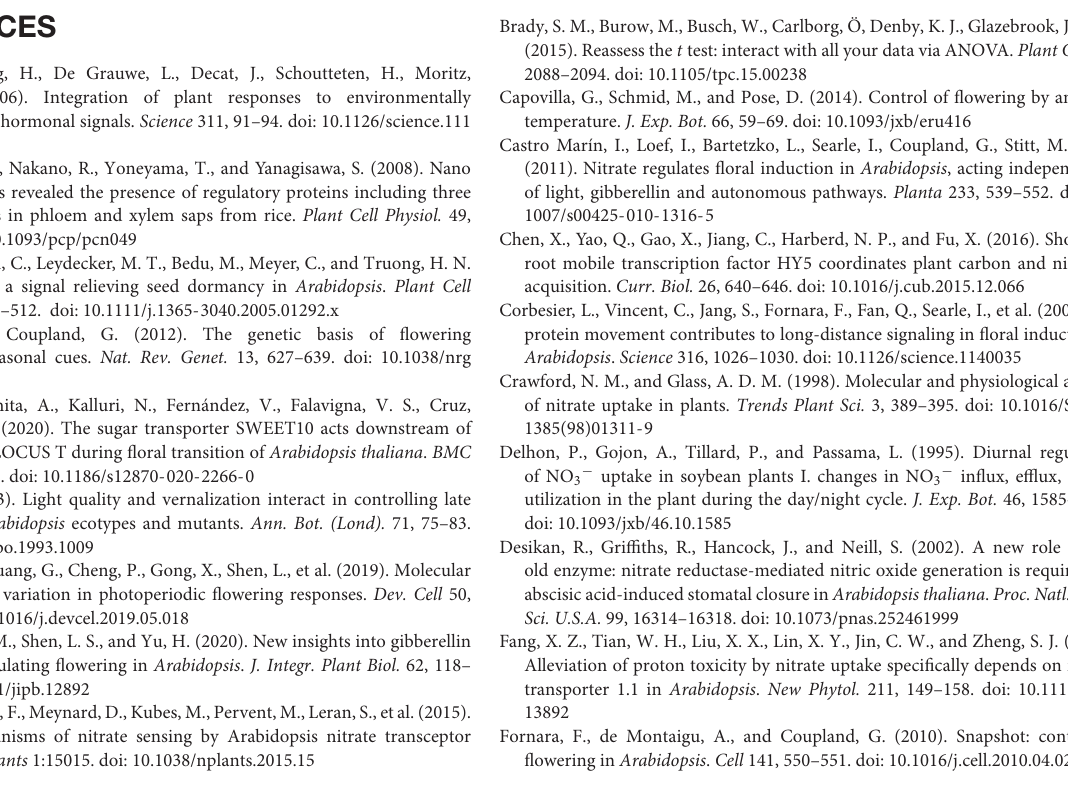
Supplementary Figure 3 | Effects of photoperiod on the bolting time of Arabidopsis Col-0 plants under a wide range of nitrate supplies. Supplementary Figure 4 | Effects of nitrate availability on the flowering time of Arabidopsis Col-0 plants in the soil system. Supplementary Figure 5 | Effects of nitrate availability on the expression of stress-related marker genes under both SD and LD conditions. Supplementary Figure 6 | Effects of ammonium availability on the flowering time of Arabidopsis Col-0 plants. Supplementary Figure 7 | Effects of the dysfunction of nitrate assimilation on the flowering response to nitrate availability. Supplementary Figure 8 | Effects of photoperiod on the expression of nitrate uptake- and assimilation-related genes. Supplementary Figure 9 | Disruption of NRT1.1 and NRT2.1 functions in nrt1.1-1/2.1-2 mutants in the soil system delayed flowering. Supplementary Figure 10 | The flowering response of nrt1.1-1/2.1-2 mutants to nitrate availability in agar system. Supplementary Figure 11 | Flowering time of grafted plants under 1 mM nitrate conditions. Supplementary Figure 12 | Expression of flowering-related genes in both Col-0 plants and nrt1.1-1/2.1-2 mutants. Supplementary Table 1 | Primers used in quantitative real-time polymerase chain reaction. Supplementary Table 2 | Effects of nitrate availability on the number of rosette leaves of ft-10 and co-1 mutants. Supplementary Table 3 | Effects of nitrate availability on flowering of the cry1